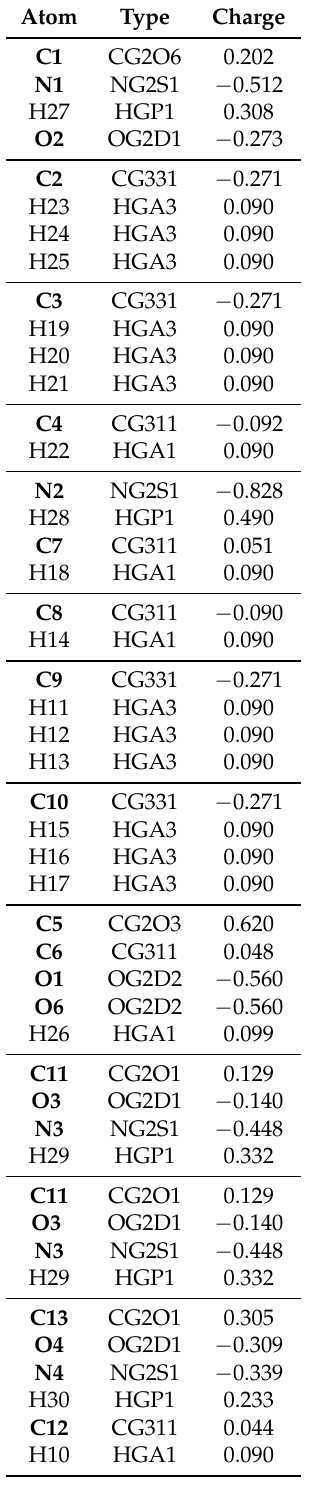
Table A2. SylA charge parameters are listed with heavy atoms in bold; groups are